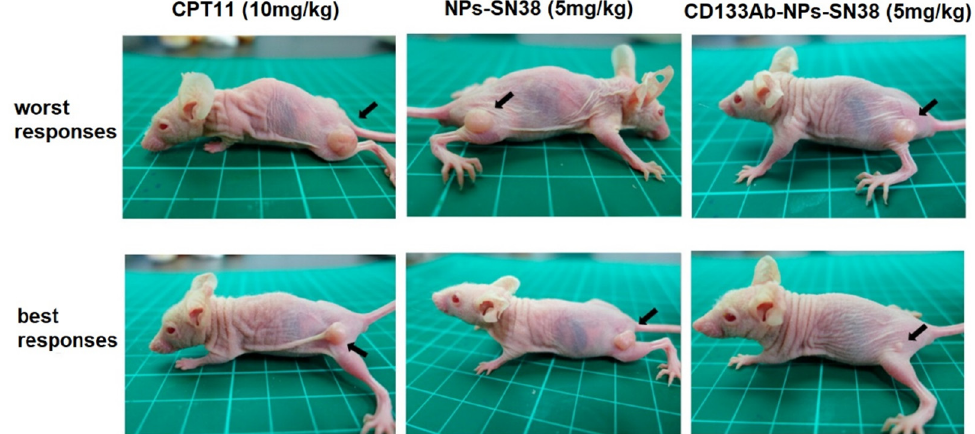
Figure 4. Comparative illustration of the tumor size in a HCT116 xenograft mouse model treated with CPT11 control group, SN-38 NPs, and CD133Ab-SN38 NPs, adapted from. Reprinted with permission from ref. [58], Copyright 2016, American Chemical Society.